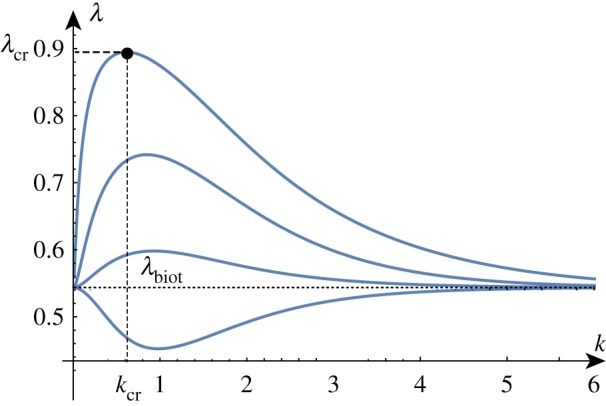
The maxima of the dispersion curves of det(M) = 0 in the λ-k plane provide the first critical values of λ at which oscillatory solutions can be obtained. For instance, the critical compression λcr and wavenumber kcr are indicated for the top curve. The curves from top to bottom are obtained for decreasing values of β∈{10, 5/2, 5/4, 5/16}. (Online version in colour.)